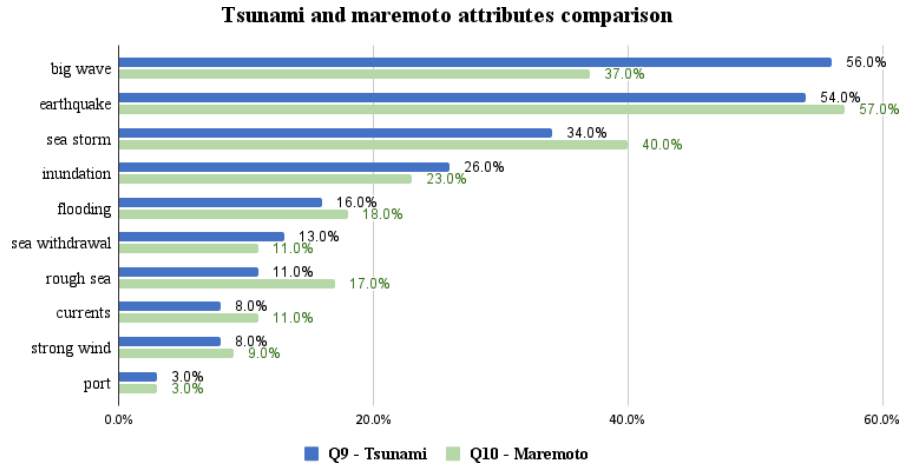
Figure 14. Tsunami and maremoto attribute